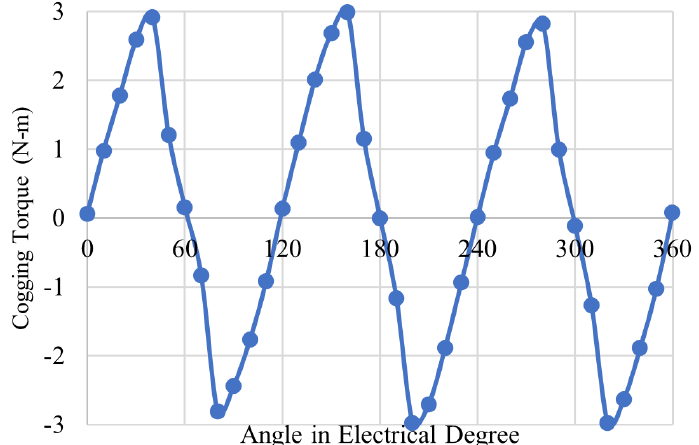
Figure 12. Average torque of different